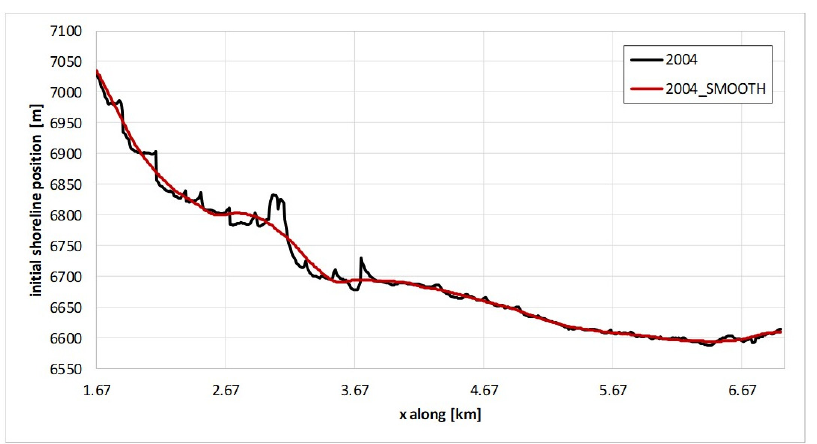
Figure 10. Shoreline position in 2004; the black line represents the unsmoothed coastline position, and the red line represents the smoothed coastline position. and the red line represents the smoothed coastline